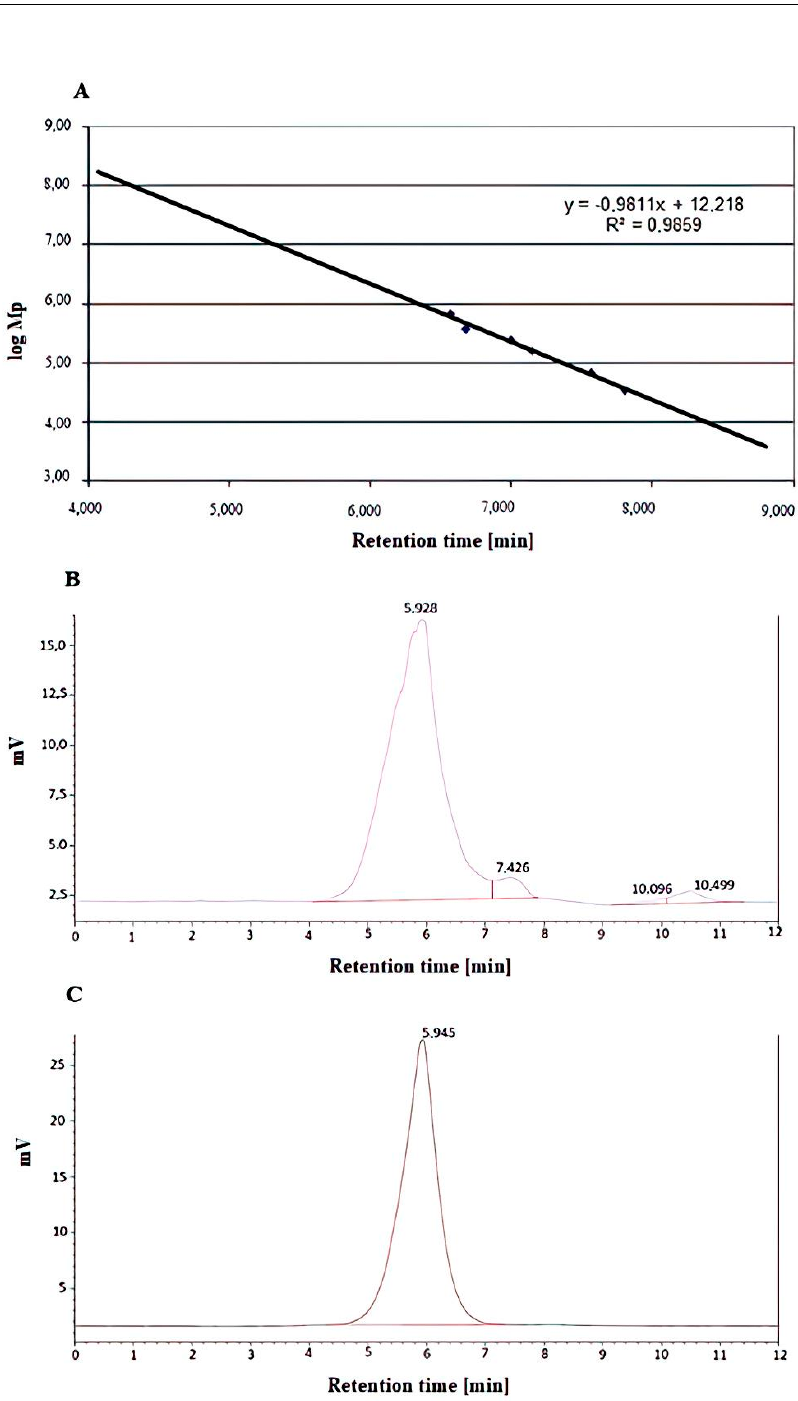
Figure 3. ( A ) Molecular weight distribution of standard β -glucans. ( B ) Chromatogram of the Le-P-0 fraction. ( C ) Chromatogram of the Le-P-Se fraction. Conditions: injection of 20 µL at a concentration of 1 mg/mL of the analyte, using a TSK gel Super Multipore PW-H 6.0 mm ID × 150 mm (TOSOH Bioscience) brand column eluted with ultrapure water (Merck, Darmstadt) as the mobile phase